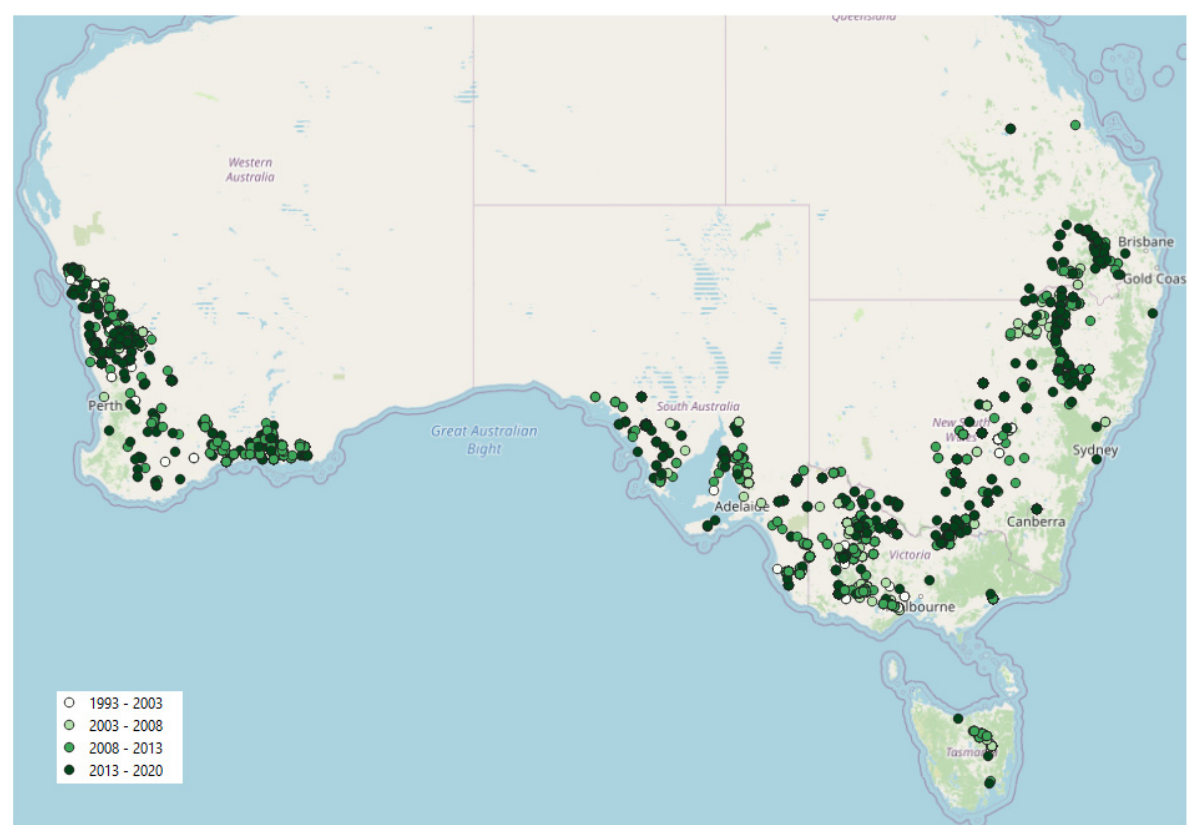
Figure 1. Spatial distribution of Trial Projects from Online Farm Trials used in analysis of sowing